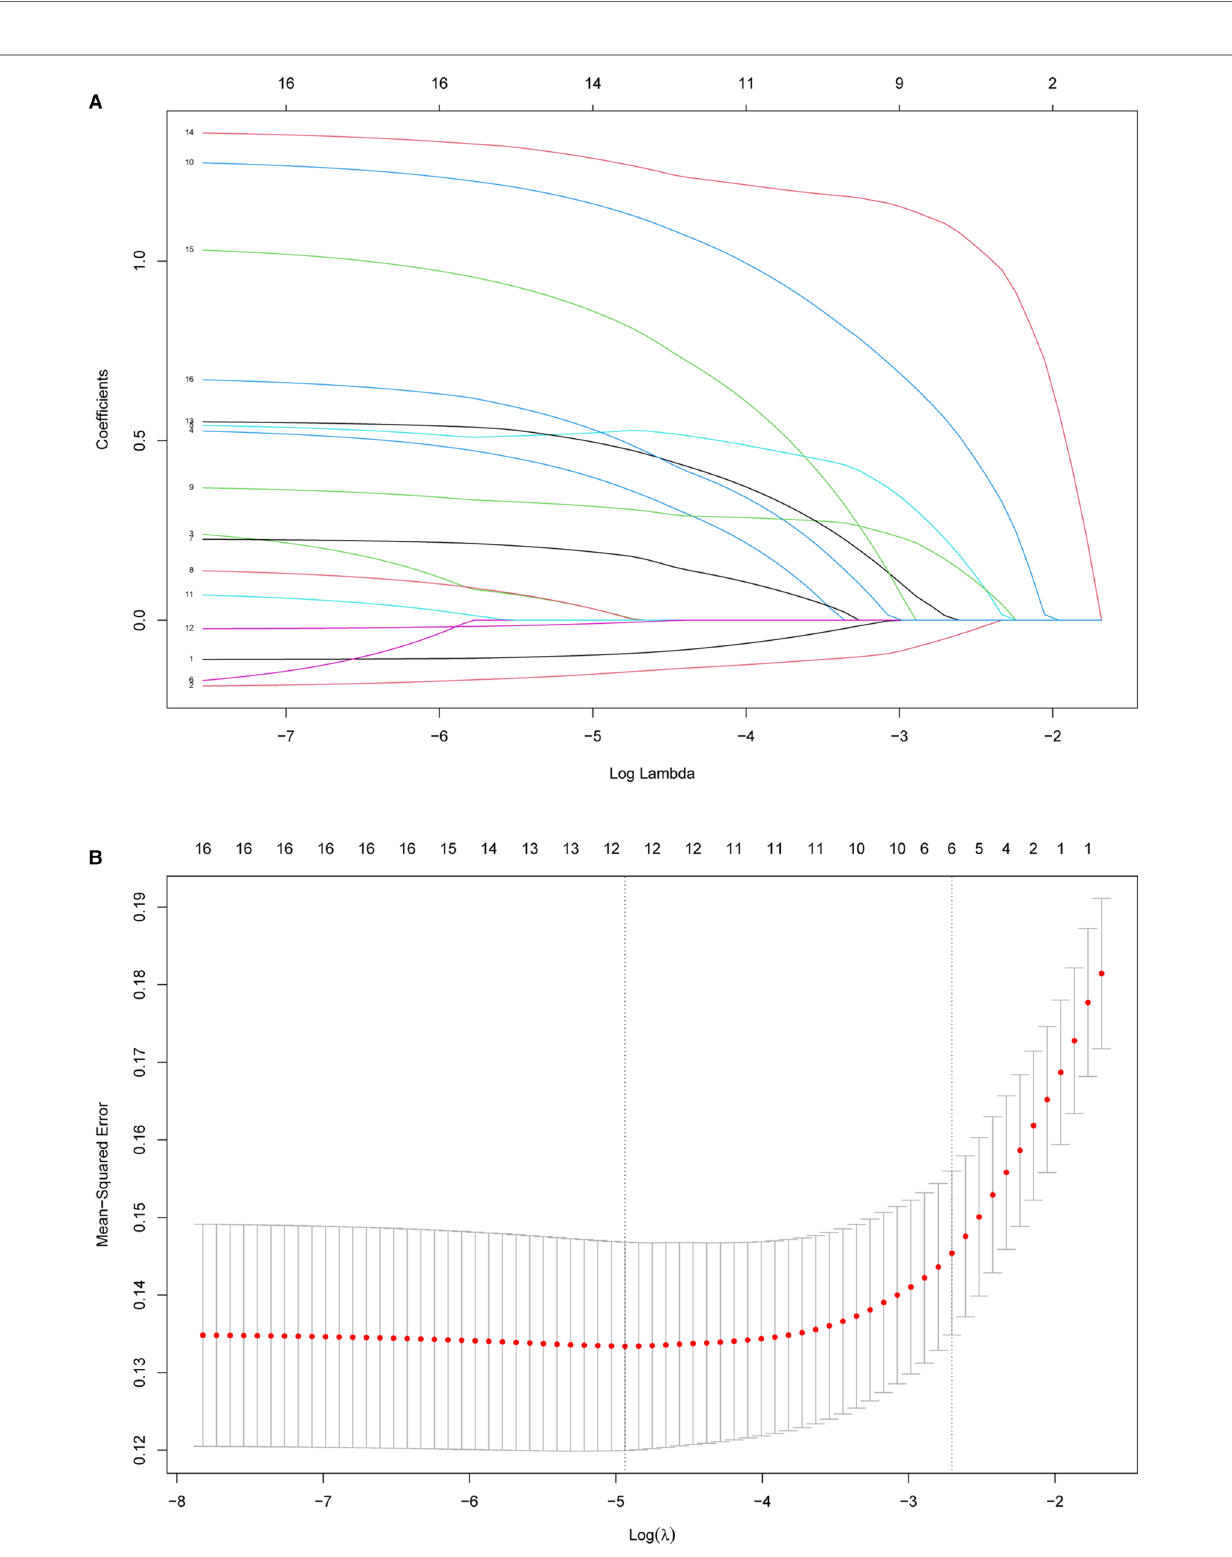
FIGURE 3 | Feature selection using the least absolute shrinkage and selection operator (LASSO) method and cross-validation. ( A ) Extracted features were reduced via the LASSO method and correlation matrix selection. ( B ) Tenfold cross-validation was used to obtain the best lambda value. The minimum log(lambda) value was about − 4.9. The vertical line of one minimal standard error was drawn at the right side of the minimum log(lambda), where optimal lambda resulted in six items with nonzero coef fi cients.